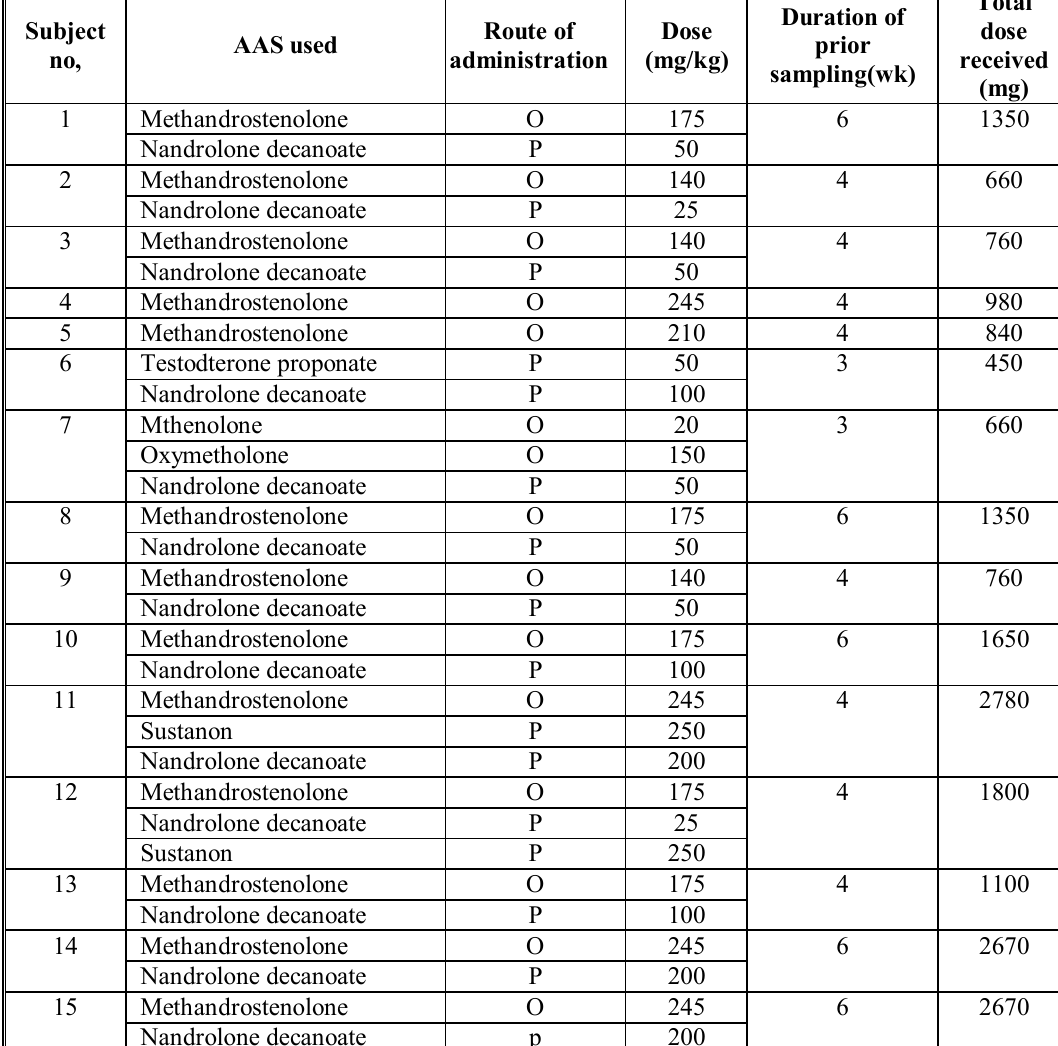
Table 1 : Dose and duration of AAS use for fifteen body